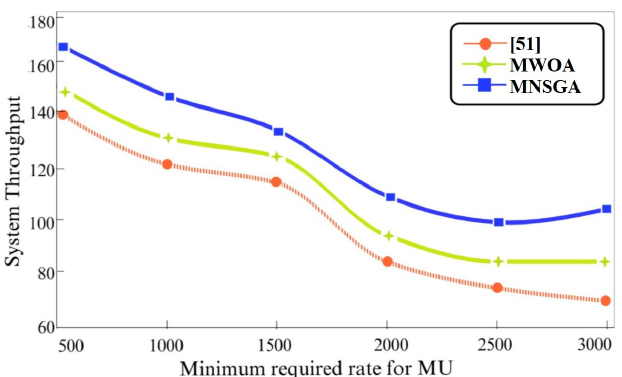
Figure 12. Throughputs for minimum distance between D2D pairs for MU s [51].